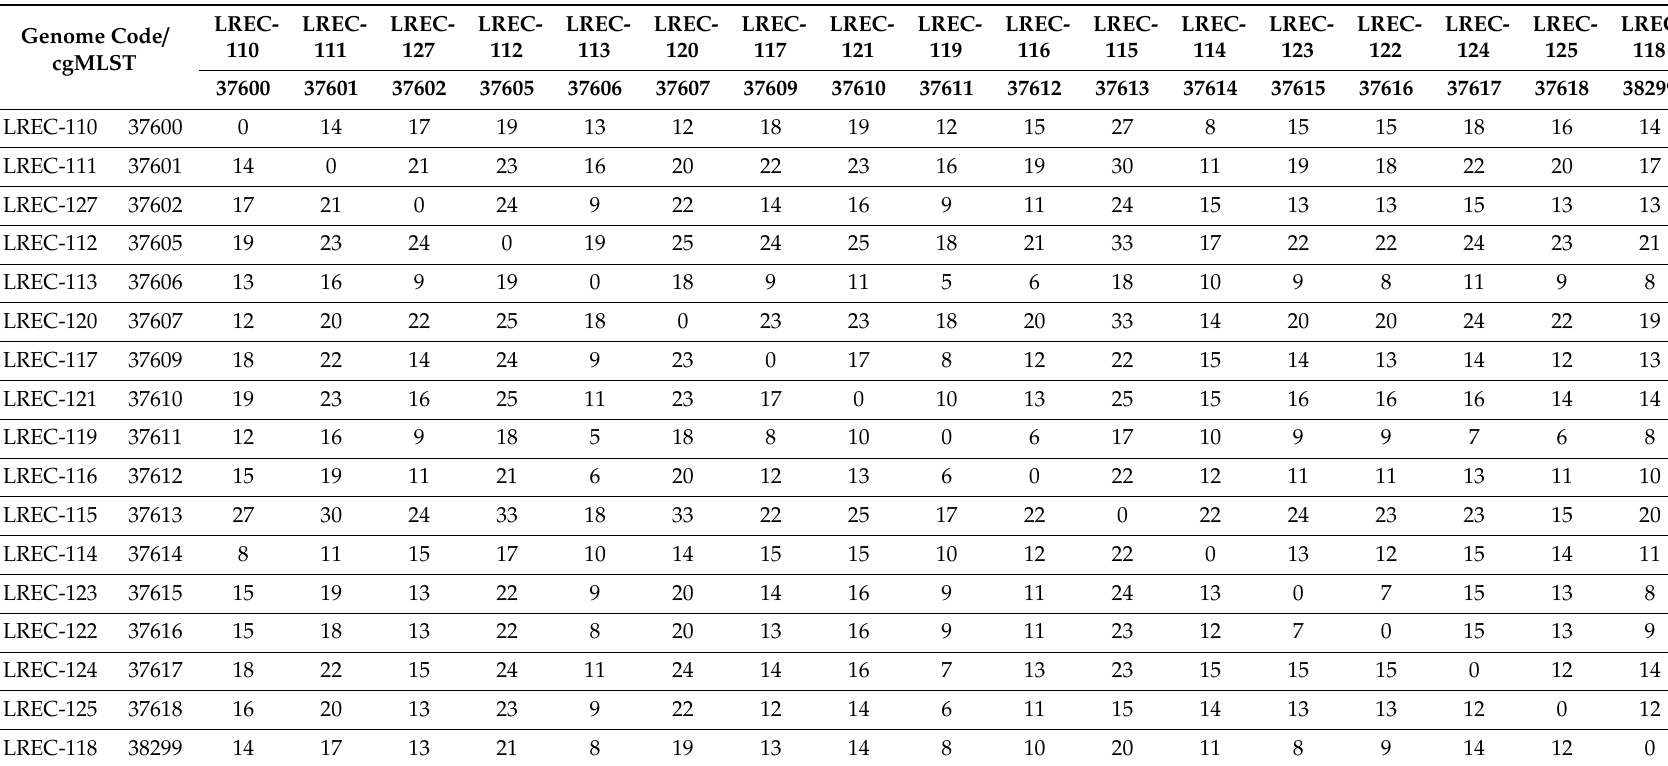
Table 3. Asymmetric distance matrix based on the cgMLST scheme from EnteroBase in which D (a, b) equals all sites that are present in (b) and di ff erent from (a). Genome Code